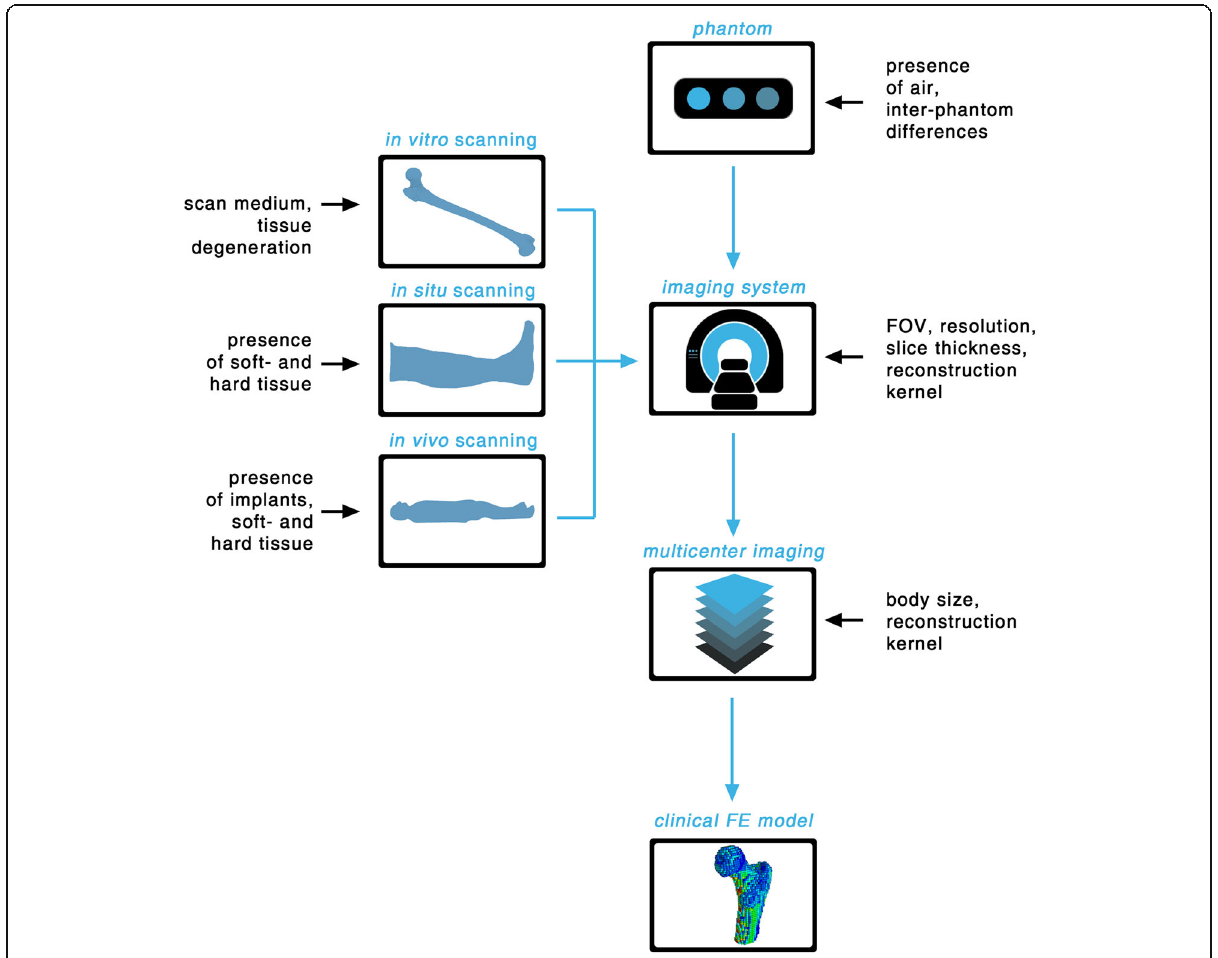
Fig. 1 Overview of potential sources for variations in quantitative computed tomography-based modelling of bone for in vitro , in situ and in vivo scanning reported in the literature. FE , Finite element; FOV , Field of view